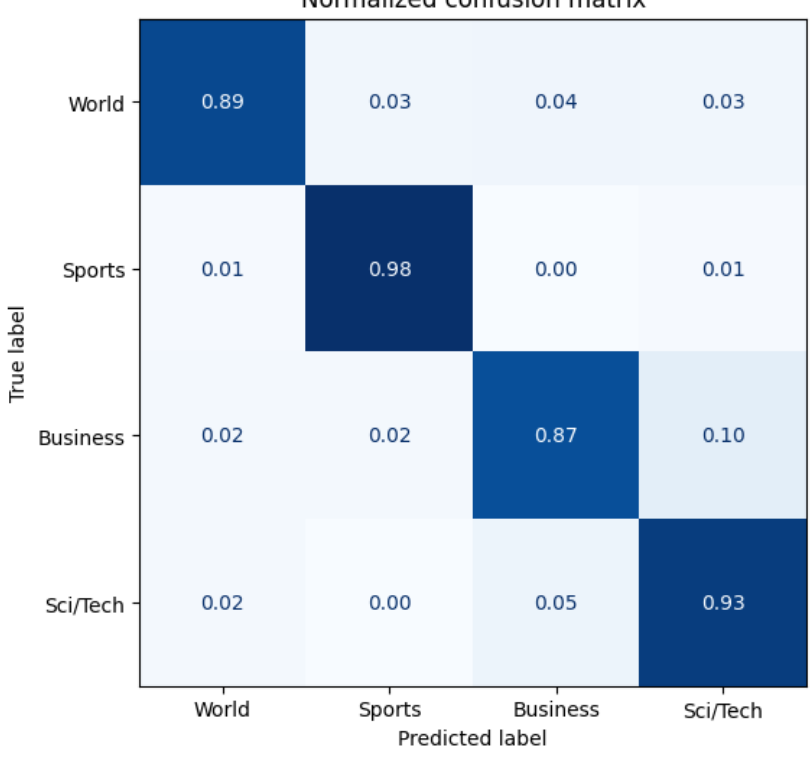
Figure A1. Antipode3 Run2 Confusion Matrix on AG-News.